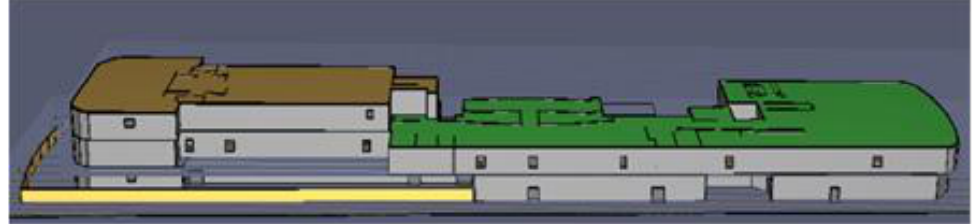
Figure 5. The 3D model of cruise ship built by